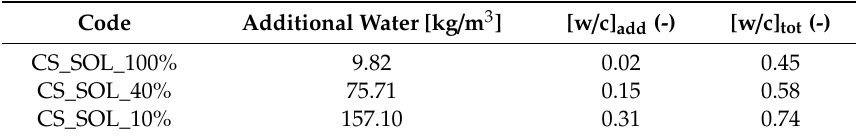
Table 2. Studied mortar mixtures with their code, amount of cross-linker, additional water and corresponding water-to-cement rations (additional and total), series